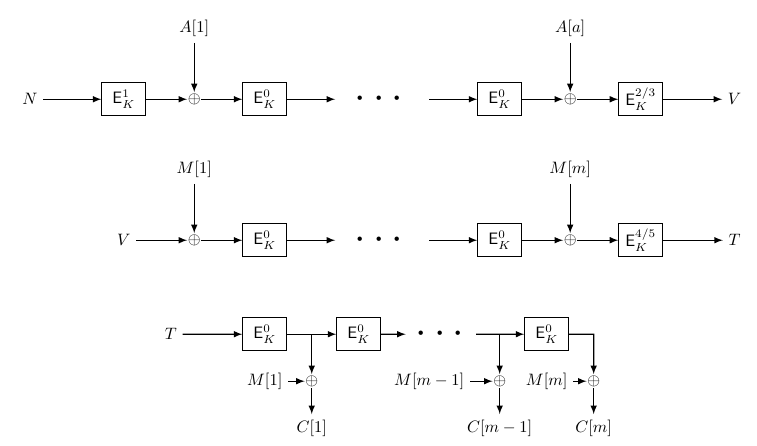
Figure 12: ESTATE with a AD blocks and m message blocks